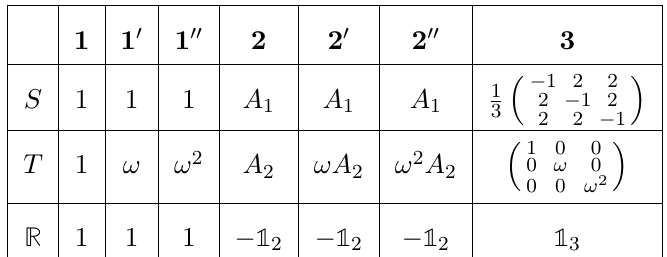
p 3 + i denotes a cubic root of unity, the matrices 2 2